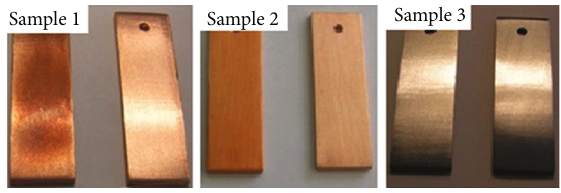
Figure 6: Corrosion test